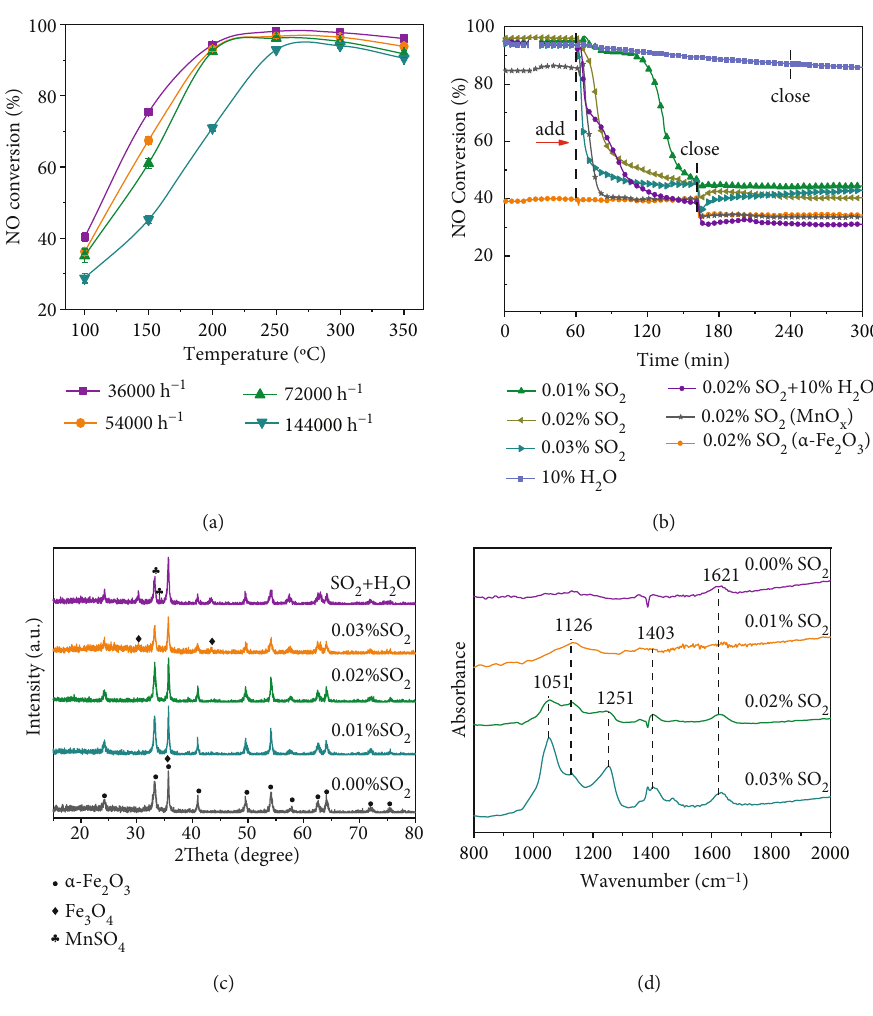
O and SO 2 O (400) poisoned by H 2 3